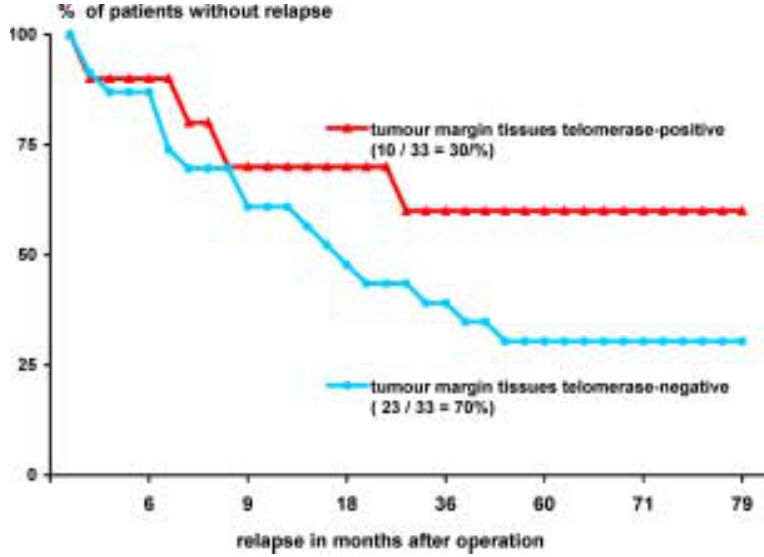
Fig. 3. Rate of relapse in relation to telomerase activity: 12 of 20 (60%) patients with tumour centre (TC) and tumour distant tissue (TD), and 20 of 33 (61%) patients with carcinoma-free tumour-margin tissues (CFM) suffered relapse in period of observation.